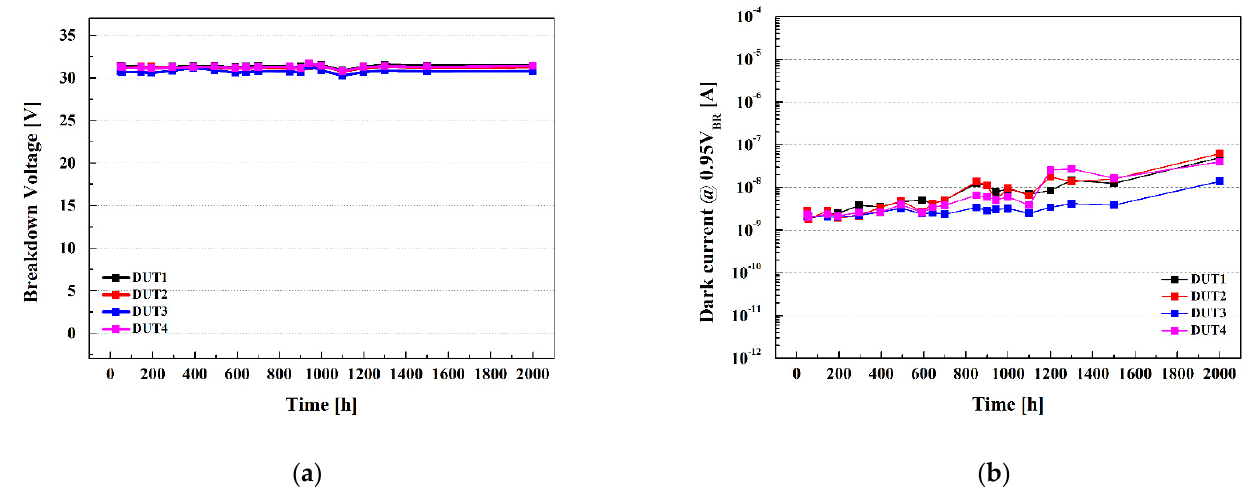
BR ) and ( b ) dark current